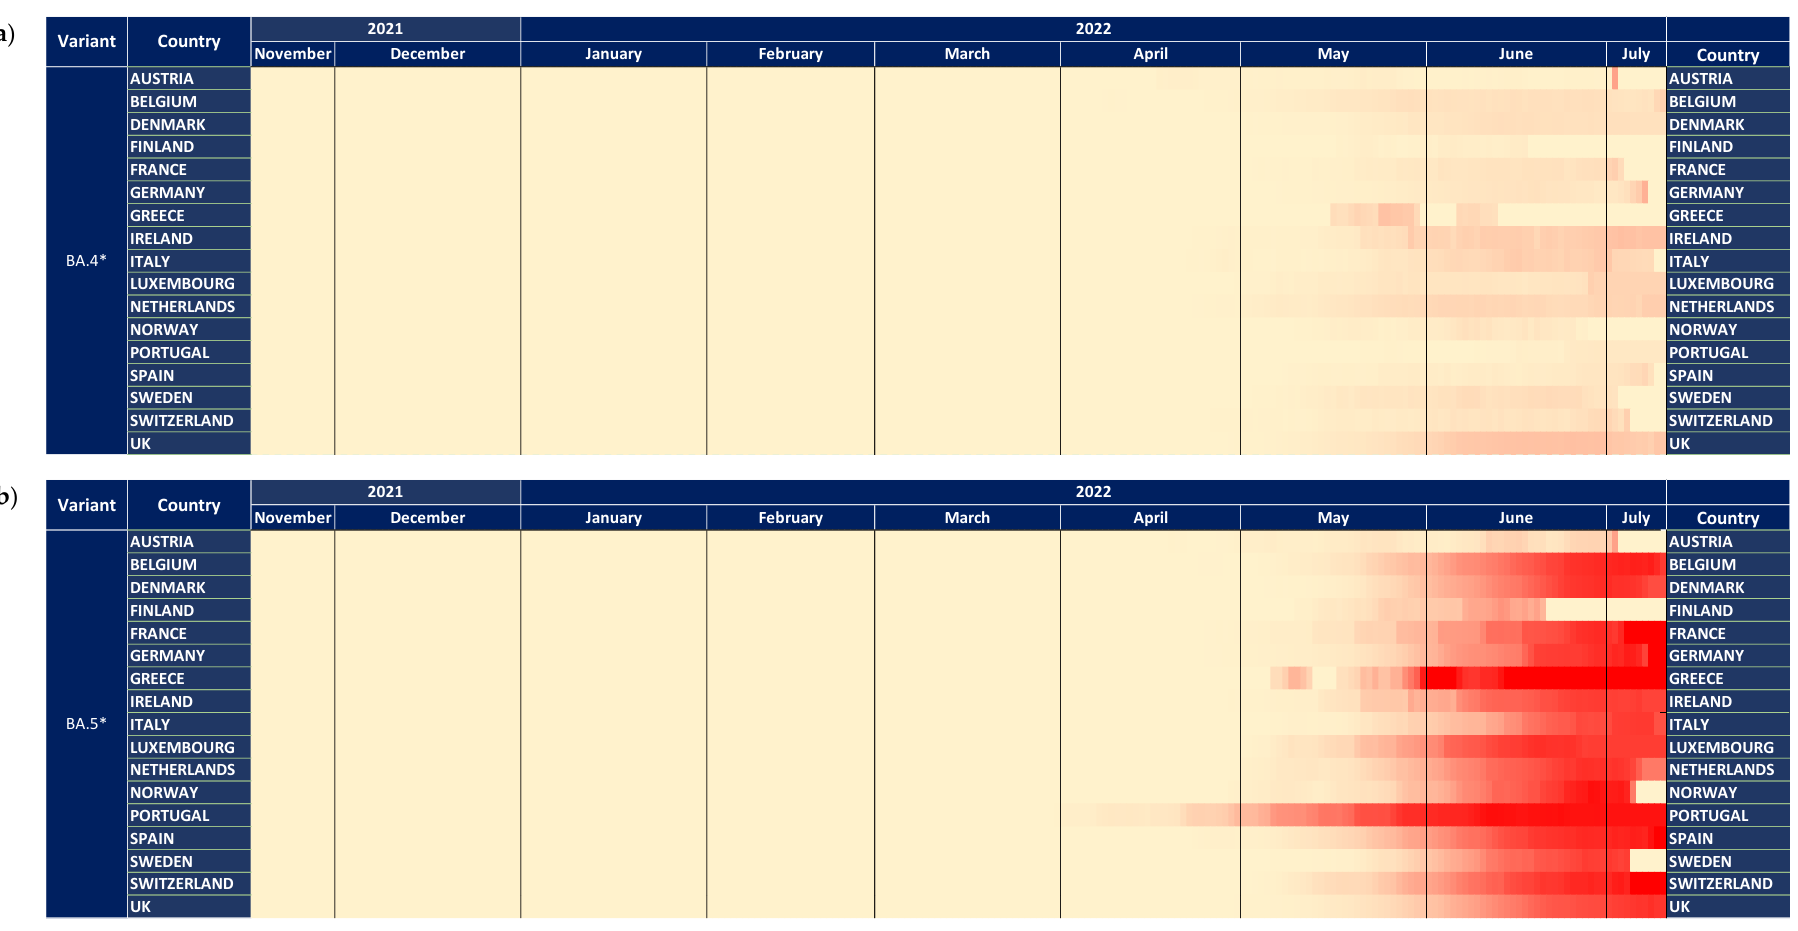
Figure 5. The dynamics of ( a ) BA.4*and ( b ) BA.5* variants across 17 European countries shown with heatmaps representing the proportion of all samples. All heatmaps shown with a maximum of 100%.